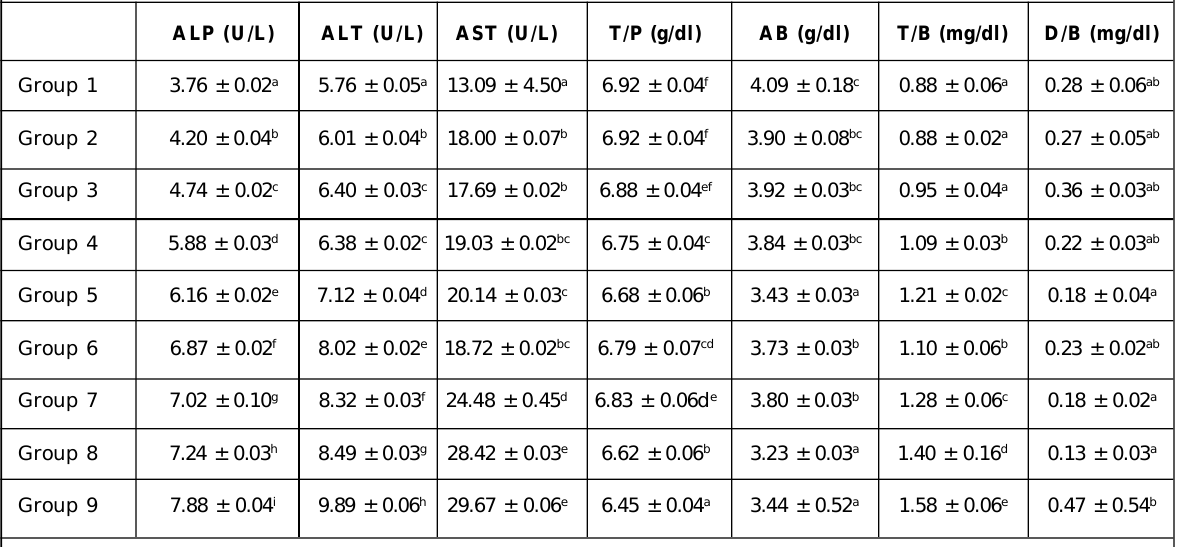
Table 2: Liver integrity assessment of female albino